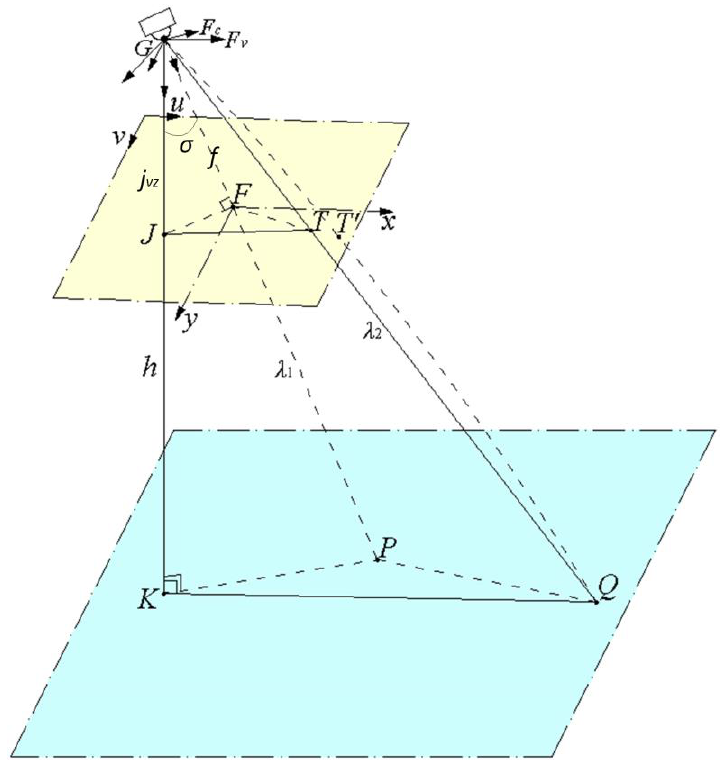
Figure 8. The location of any target in image model.